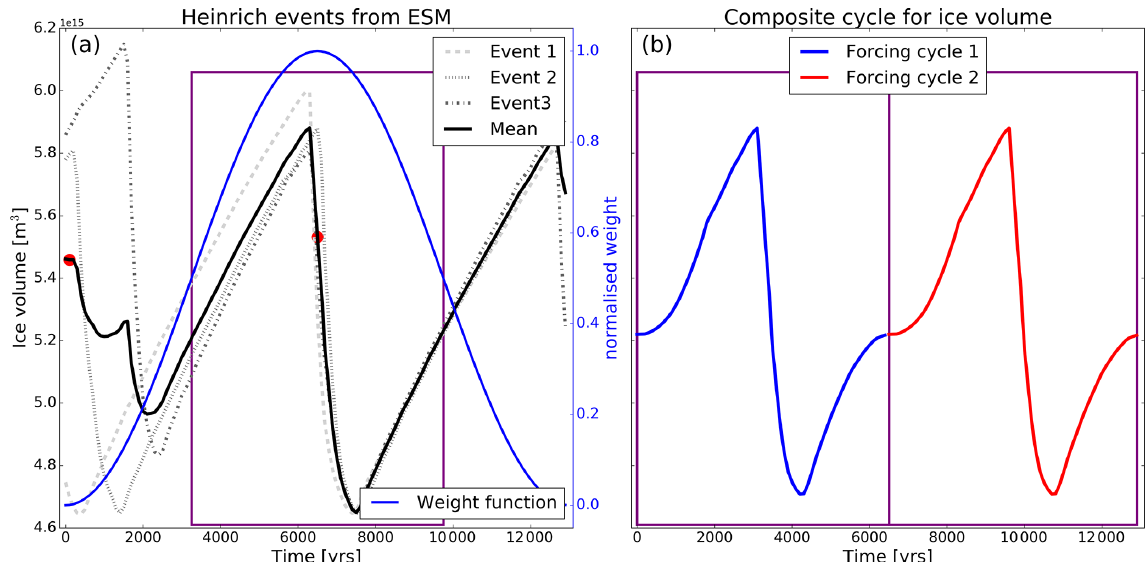
Figure 2. (a) Construction of composite forcing from individual ice-sheet surge events of Hudson ice stream from an MIS3 simulation with the MPI-ESM–mPISM–VILMA model system. Red dots indicate the start points for the application of the weighting function from which the final forcing is generated. Panel (b) shows two cycles of ice volume changes from the composite forcing after the application of the weight function. There is a smooth transition from one forcing cycle to the next. The purple box in (a) corresponds to two forcing cycles shown in (b) after the application of the weight function.